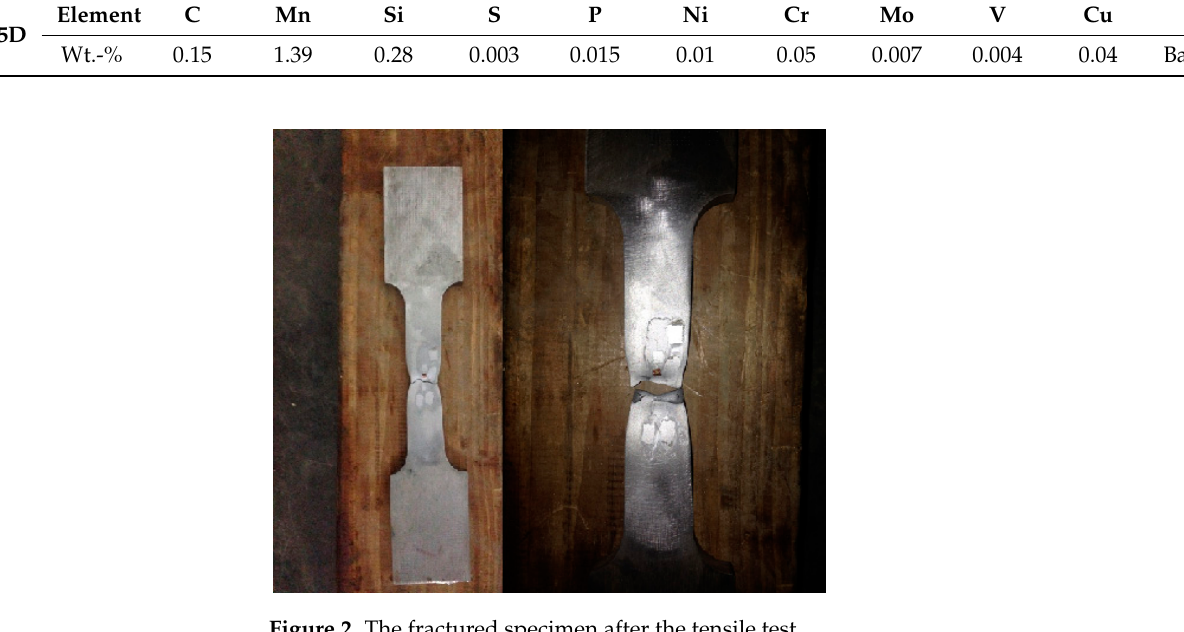
Figure 2. The fractured specimen after the tensile test.